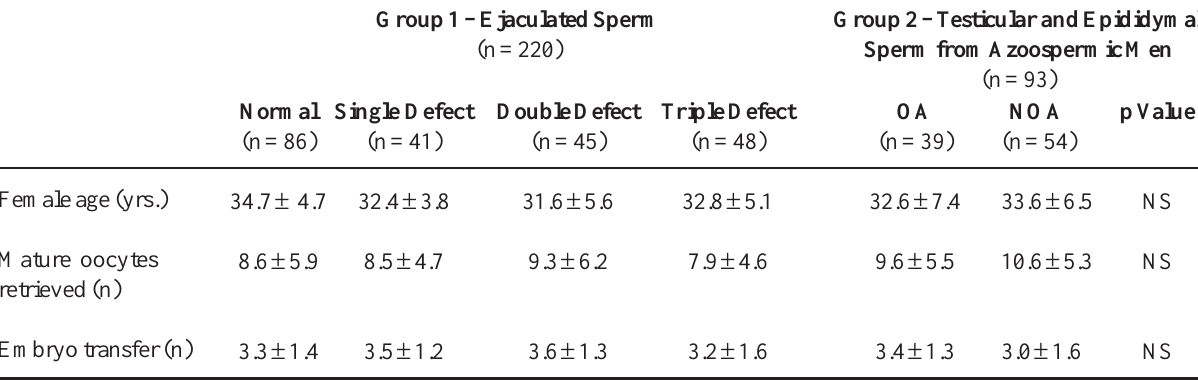
Table 1 – Descriptive statistics from group 1 (ejaculated sperm subdivided according to the severity of sperm deficiency) and group 2 (testicular/epididymal sperm) including female age, number of mature oocytes (MII) retrieved following follicle aspiration, number of pre-embryos transferred to the uterine cavity. Values are mean ± SD.